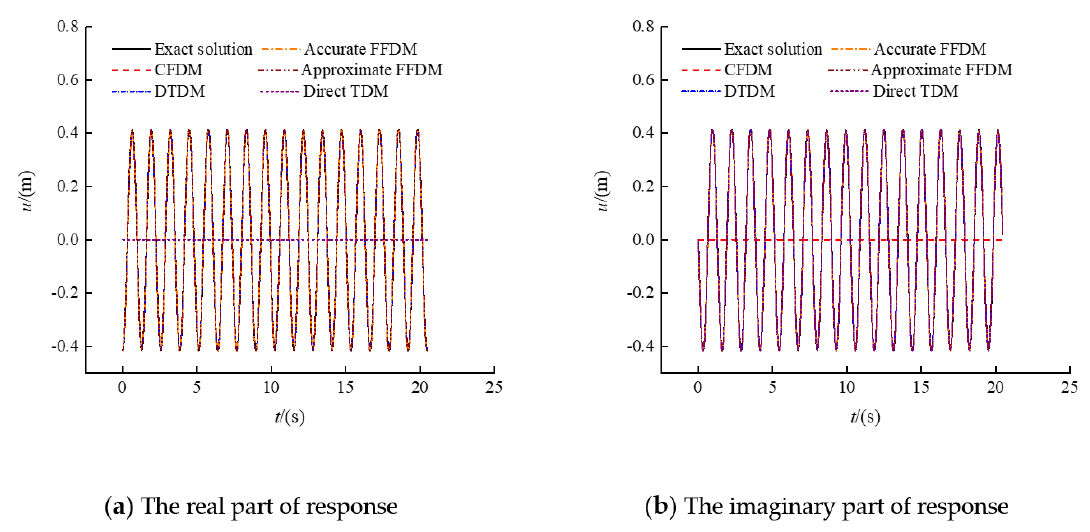
Figure 3. Displacement response time history under zero mean sine force ( θ / ω 1 = ). Table 1. The relative errors of the amplitude of displacements under a zero mean value force (%).